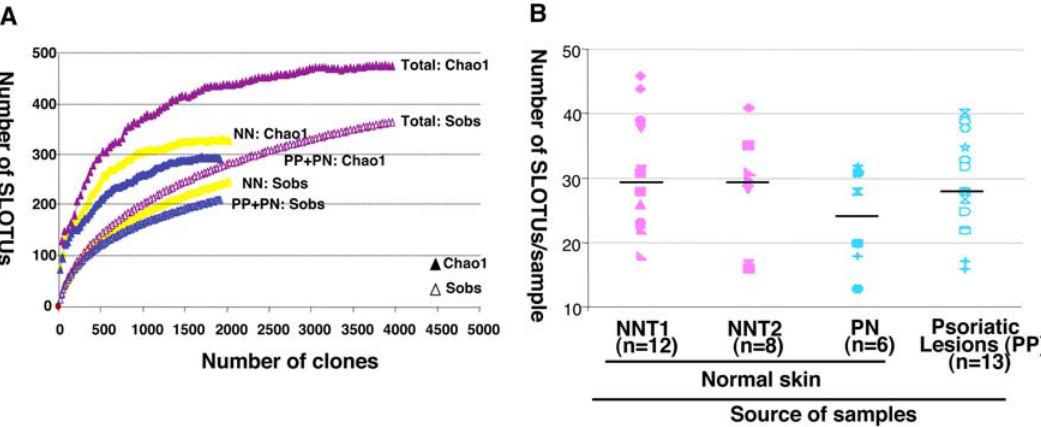
Figure 1. Diversity of bacterial species in 39 skin specimens from 12 subjects. Panel A. Collector’s curves of SLOTU richness of pooled skin samples from six healthy subjects and six patients with psoriasis. Each curve reflects the observed (Sobs) or estimated (Chao1) richness values obtained in 3 different groups of 16S rDNA clones. PP + PN indicates the 1,925 (1,314 from psoriatic lesion and 611 from uninvolved skin, respectively), clones from six patients with psoriasis, added to the data set in an arbitrary order. NN includes 2,038 clones from healthy persons reported in a prior study [11]. Overall, the sequences detected from the (Total) 39 human skin specimens from these studies represent 366 different SLOTUs, whereas the Chao1 score estimates that the skin bacterial biota contains 476 SLOTUs. Based on this prediction, Good’s estimator of coverage is 96.9%. Panel B. Diversity at the species level. The 20 samples from 6 healthy subjects (pink) and 19 samples from 6 patients with psoriasis (blue) are indicated by the color designations. NNT1 (n=12) represents left and right forearm skin for six subjects, NNT2 (n=8) represents the resampling of four subjects 8–10 months later [11]. PN (n=6) represents uninvolved skin from six patients with psoriasis. The samples from healthy subjects and from uninvolved skin from psoriatic patients are indicated with solid symbols, and the samples from psoriatic lesions are indicated with open symbols. All samples from the same subject are indicated by the same symbol. For each group, the horizontal line indicates the median of the number of SLOTU.